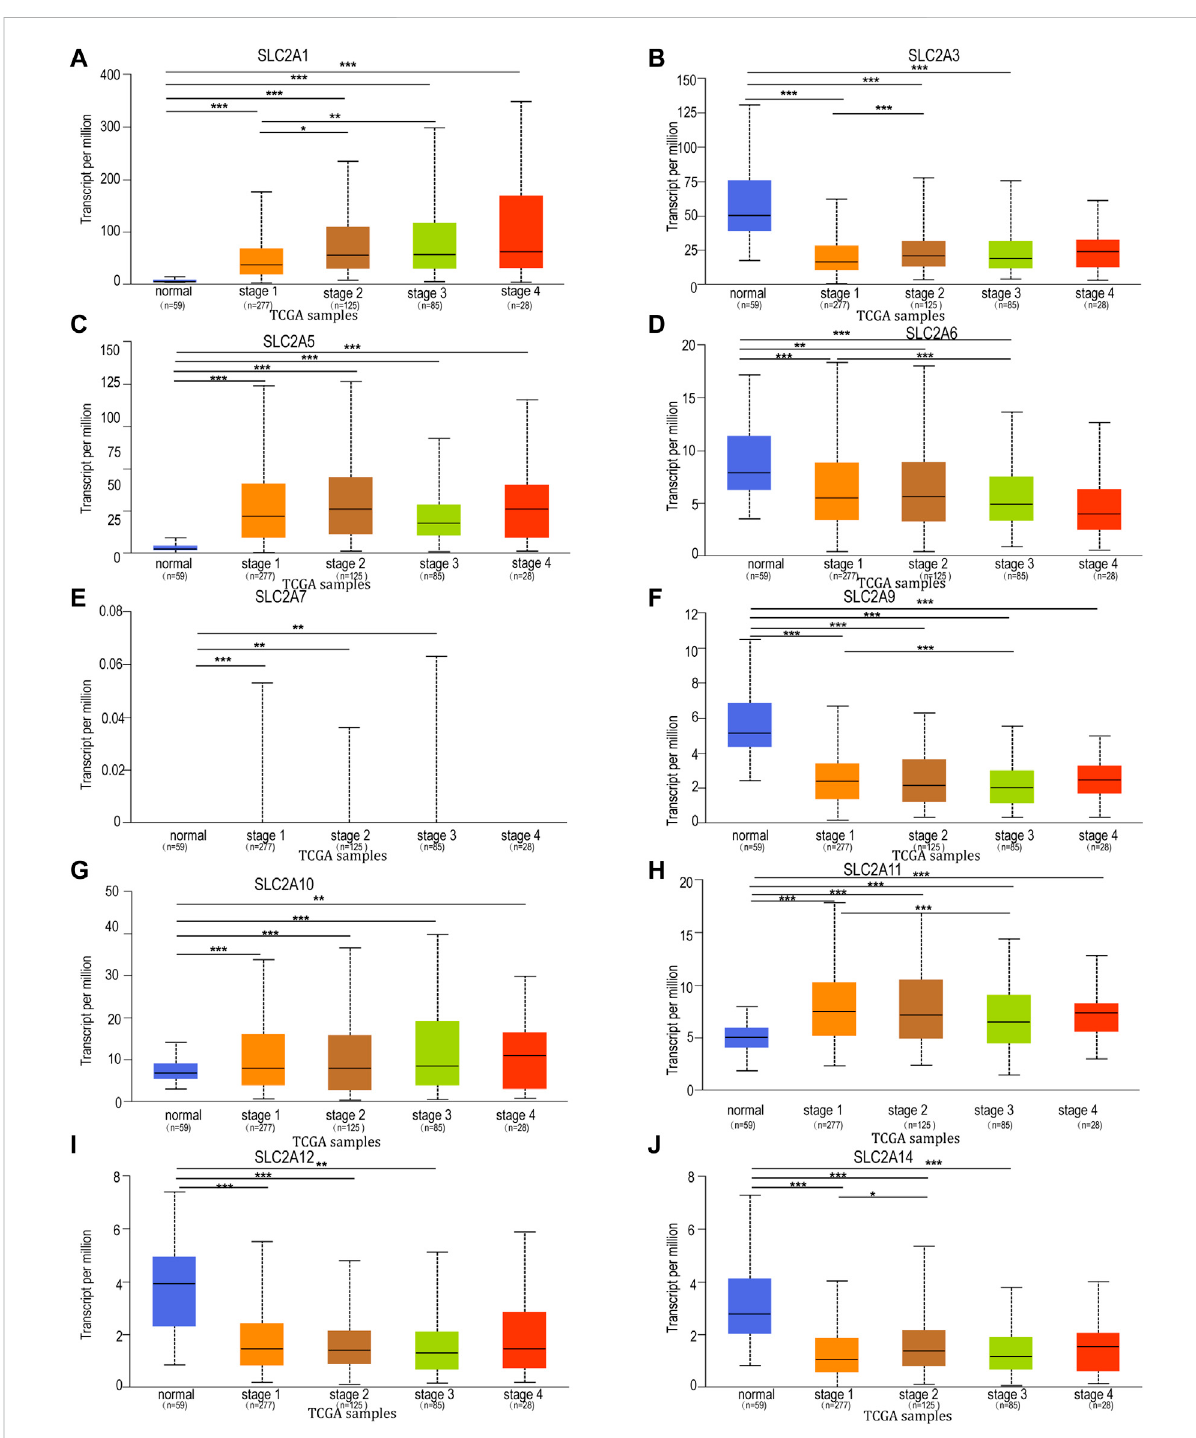
FIGURE 3 Relationship between mRNA expression of distinct SLC2As and individual cancer progression of LUAD patients. mRNA expressions of SLC2As were remarkably correlated with patients ’ individual cancer stages. (A,C,G,H) Patients who were in more advanced stages tended to express higher mRNA expression of SLC2A1 , SLC2A5 , SLC2A10 , SLC2A11 . The highest mRNA expressions of, SLC2A5 , SLC2A10 , SLC2A11 were found in stage 4. (B,D,F,I,J) Patients who were in more advanced stages tended to express lower mRNA expression of SLC2A3 , SLC2A6 , SLC2A9 , SLC2A12 and SLC2A14 . (A – I) Inaddition, SLC2A1 , SLC2A3 , SLC2A5 , SLC2A6 , SLC2A7 , SLC2A9 , SLC2A10 , SLC2A11 , SLC2A12 , SLC2A14 expressionsweredifferentin stage 1 from that in normal group. * p < 0.05, ** p < 0.01, *** p <